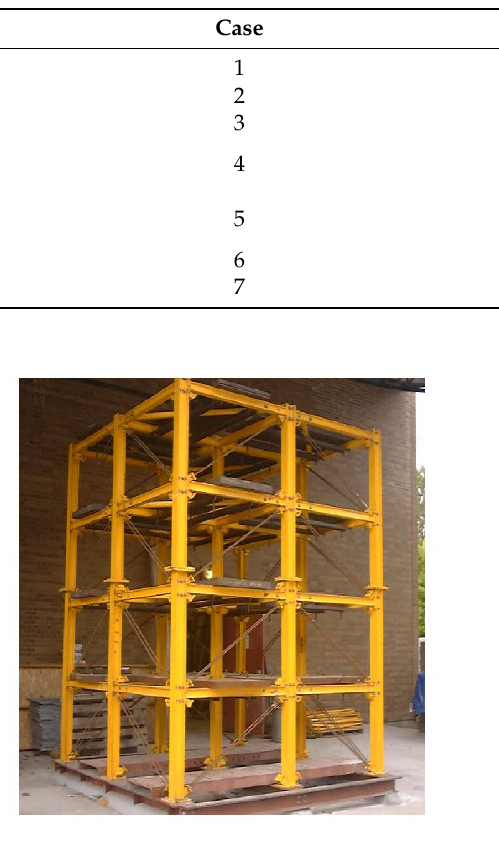
Figure 5. ASCE experimental SHM benchmark structure: experimental model (excerpt from